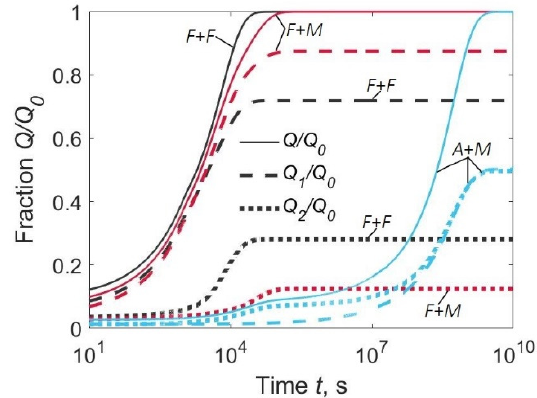
Figure 6. Fraction of hydrogen evolved from the upper surface ( Q 1 / Q 0 ), lower surface ( Q 2 / Q 0 ), and both surfaces ( Q / Q 0 ) for welded joints of three types: F + F , F + M , and A + M . C 02 / C 01 = 0.1.